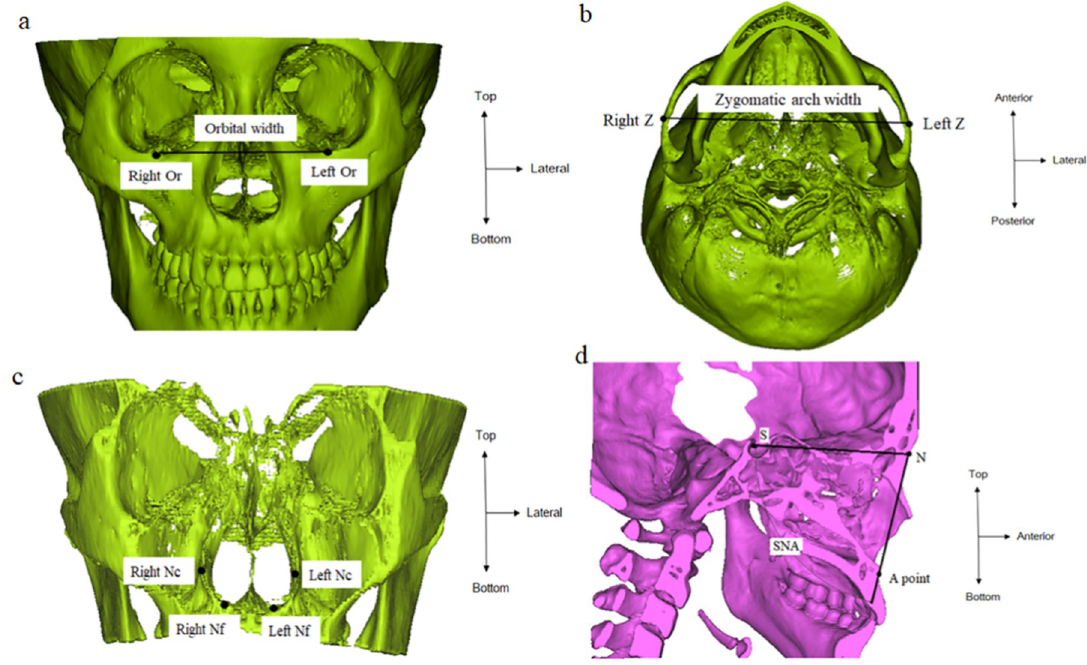
Fig 1. (A) Orbital width (B) Zygomatic width (C) Nasal cavity width and nasal base width (D) SNA, the angle between the Sella-Nasion line and the Nasion-A point line. Or, orbitale; Z, zygomatic process; Nc, the lateral-most points of the nasal cavity; Nf, the junction of the palatal cortical alveolar bone and cortical nasal bone.